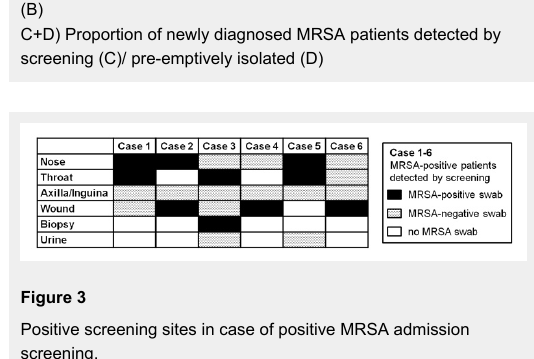
Positive screening sites in case of positive MRSA admission screening. Swabs of axilla/inguina did not increase the sensitivity of the admission